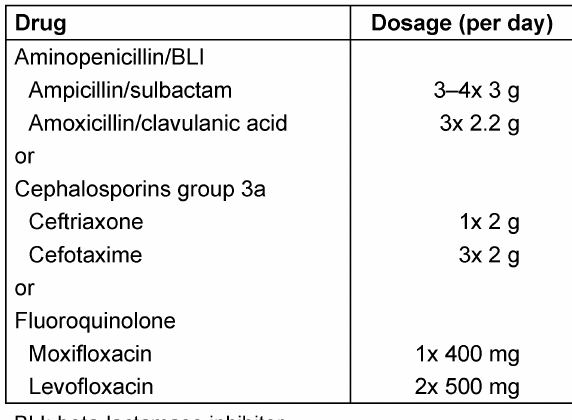
Table 10: Calculated initial treatment for nosocomial pneumonia without risk factors for multidrug